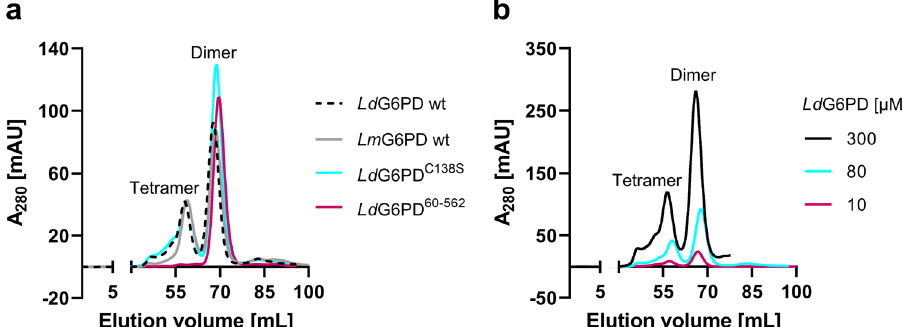
Fig. 1 SEC analysis of recombinant Ld G6PD and Lm G6PD wt and of Ld G6PD mutants under native conditions. Full-length G6PD was gel- fi ltrated on a HiLoad 16/60 Superdex 200 column pre-equilibrated in buffer A (500 mM NaCl, 50 mM Tris, pH 7.8). a The SEC pro fi les of Ld G6PD wt (66.7 kDa) (black dotted, retention volume (rv) 1. peak = 58 mL = 300 kDa, rv 2. peak = 68 mL = 133 kDa) and Lm G6PD wt (66.8 kDa) (gray, rv 1. peak = 59 mL = 276 kDa, rv 2. peak = 68 mL = 133 kDa) display two peaks with elution patterns equivalent to a dimer and a tetramer and remained stable in the Ld G6PD C138S mutant (66.7 kDa) (blue, rv 1. peak = 59 mL = 276 kDa, rv 2. peak = 68 mL = 133 kDa). The SEC pro fi le of the Ld G6PD 60-562 mutant (60.3 kDa) displays one peak with elution patterns equivalent to a dimer (red, rv = 69 mL = 112 kDa). b SEC pro fi les of Ld G6PD wt under different enzyme concentrations, 300 µ M (black, rv 1. peak = 56 mL = 341 kDa, 2. Peak = 66 mL = 156 kDa), 80 µ M (blue, rv 1. peak = 58 mL = 300 kDa, rv 2. peak = 68 mL = 133 kDa), and 10 µ M (red, rv 1. peak = 57 mL = 325 kDa, rv 2. peak = 67 mL = 144 kDa) display two peaks with stable elution patterns equivalent to a dimer and a tetramer. Representative chromatograms ( n ≥ 2) are shown for each